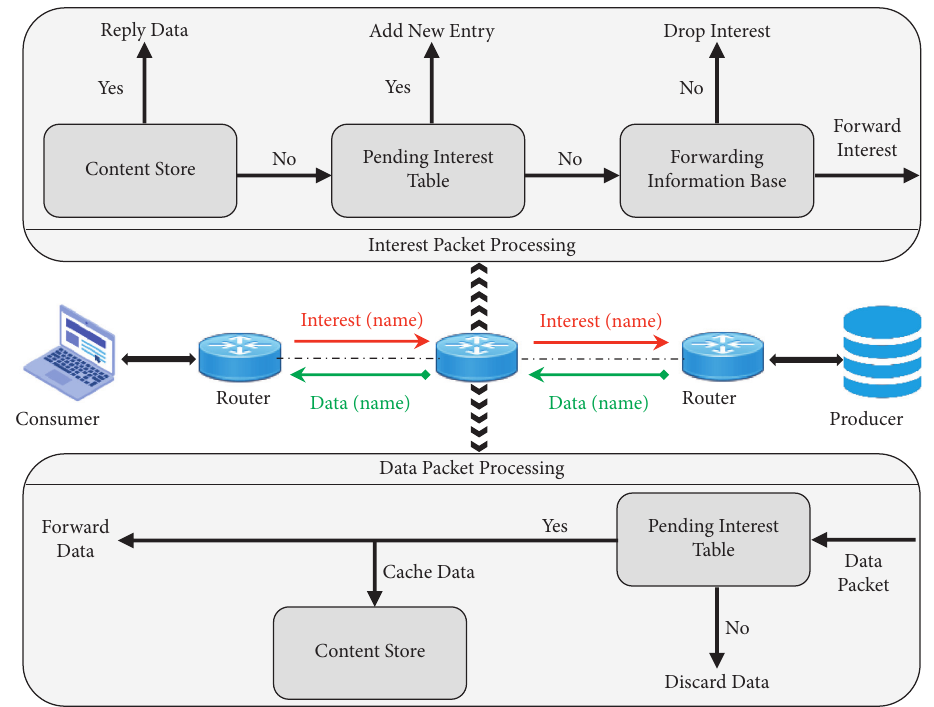
Figure 2: Interest and Data packets processing in